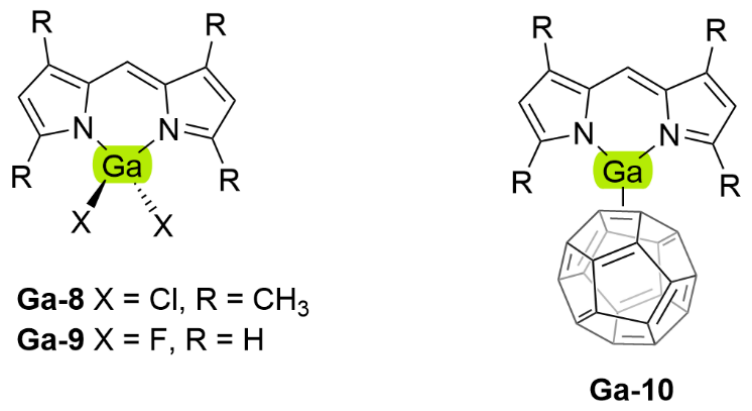
Figure 32. Chemical structures of monomeric Ga(III) complexes (GaDIPYs) reported in literature.